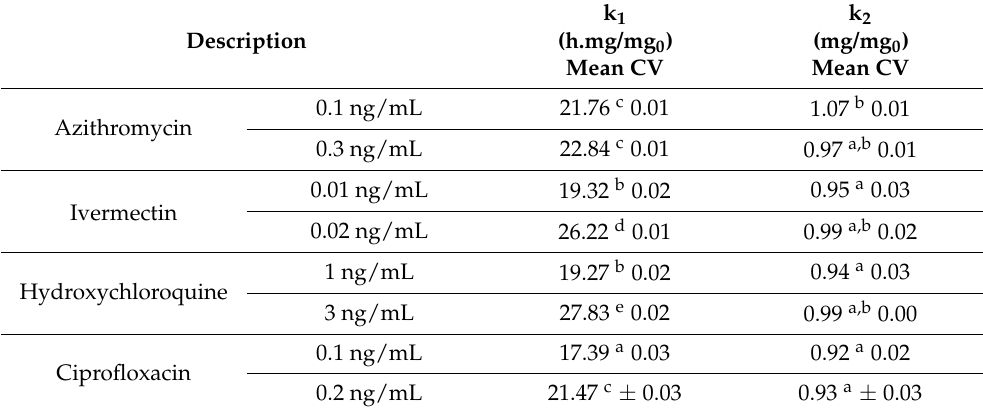
Table 1. Peleg’s constants of the diffusion of polyphenols during the fermentation process.